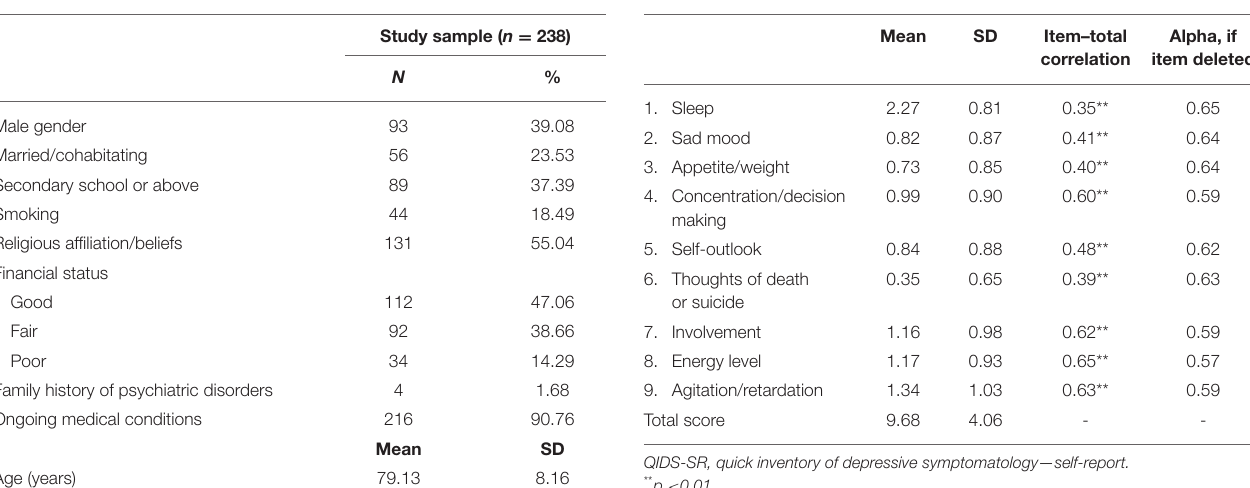
TABLE 1 | Basic demographic and clinical characteristics of the study sample. TABLE 2 | QIDS-SR ratings at